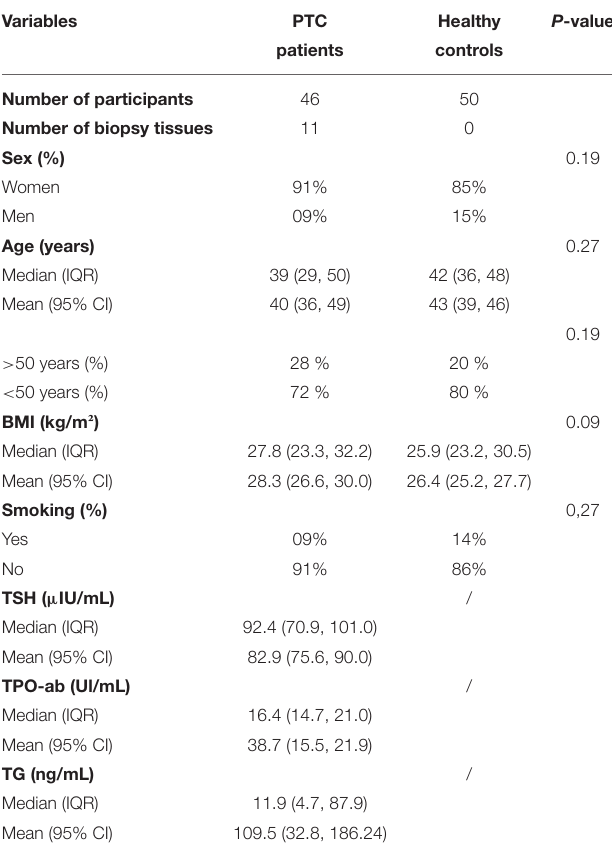
TABLE 1 | Characteristics of the study